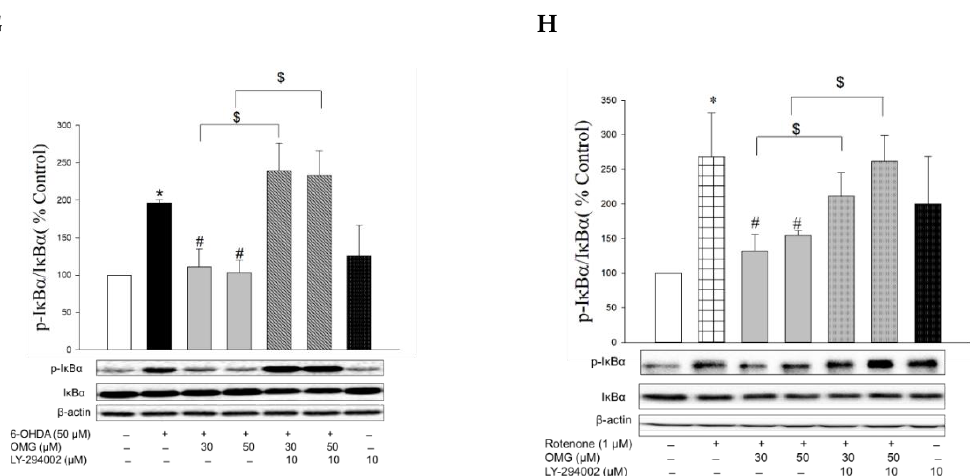
Figure 8. Induction of Akt phosphorylation by OMG and its role in the regulation of NF-κB signaling in PC12 cells. ( A , B ) PC12 cells were pretreated with OMG (30 and 50 μM) for 4 h, subsequently exposed to ( A ) 6-OHDA or ( B ) rotenone for 6 h, and the levels of phosphorylated Akt (p-Akt) were determined by western blotting using anti-p-Akt antibody, as described in the Materials and Methods section. ( C – H ) PC12 cells were pretreated with LY294002 (10 μM) for 2 h, followed by treatment with OMG (30 and 50 μM) for 4 h, and then exposed to ( C , D , G ) 6-OHDA or ( E , F , H ) rotenone for an additional 6 h. ( C , E ) Cytosolic and ( D , F ) nuclear levels of ( G , H ) NF-κB or phosphorylated IκBα (p-IκBα) were determined by western blotting using anti-NF-κB antibody and anti-p-IκBα or anti-IκBα antibodies, respectively, as described in the Materials and Methods. Band intensity was quantified by densitometric analyses. Cytosolic and nuclear levels of NF-κB were normalized to β-actin and lamin-B, respectively. P-IκBα levels were normalized to non-p-IκBα and β-actin. Data are displayed as the mean ± SEM from at least three independent experiments. *, p < 0.05 vs. the vehicle-treated control cells; # , p < 0.05 vs. 6-OHDA- or rotenone-treated cells; $ , p < 0.05 vs. cells treated with 6-OHDA or rotenone and OMG. OMG, omarigliptin; NF-κB, nuclear factor-kappa B; 6-OHDA, 6-hydroxydopamine.